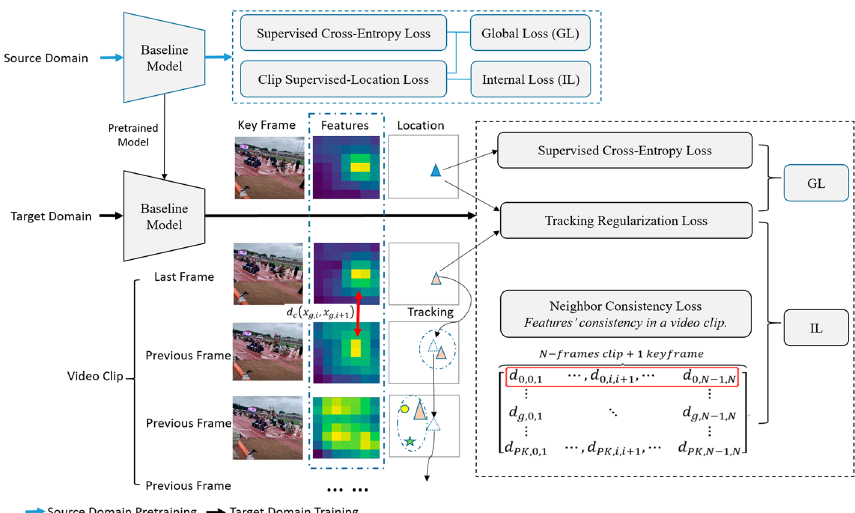
Fig. 2 Overall framework. In source domain, we trained the network on the first data set, which has both location and classification annotations. In target domain, we trained the network with the pre-trained model on the second data set, which only has action classification temporal annotations. To ensure the continuity of the target in the video sequence, Tracking-regularization loss is calculated by a tracker between the tracking location and network’s predicted location. The neighbor-consistency loss makes the features of objects